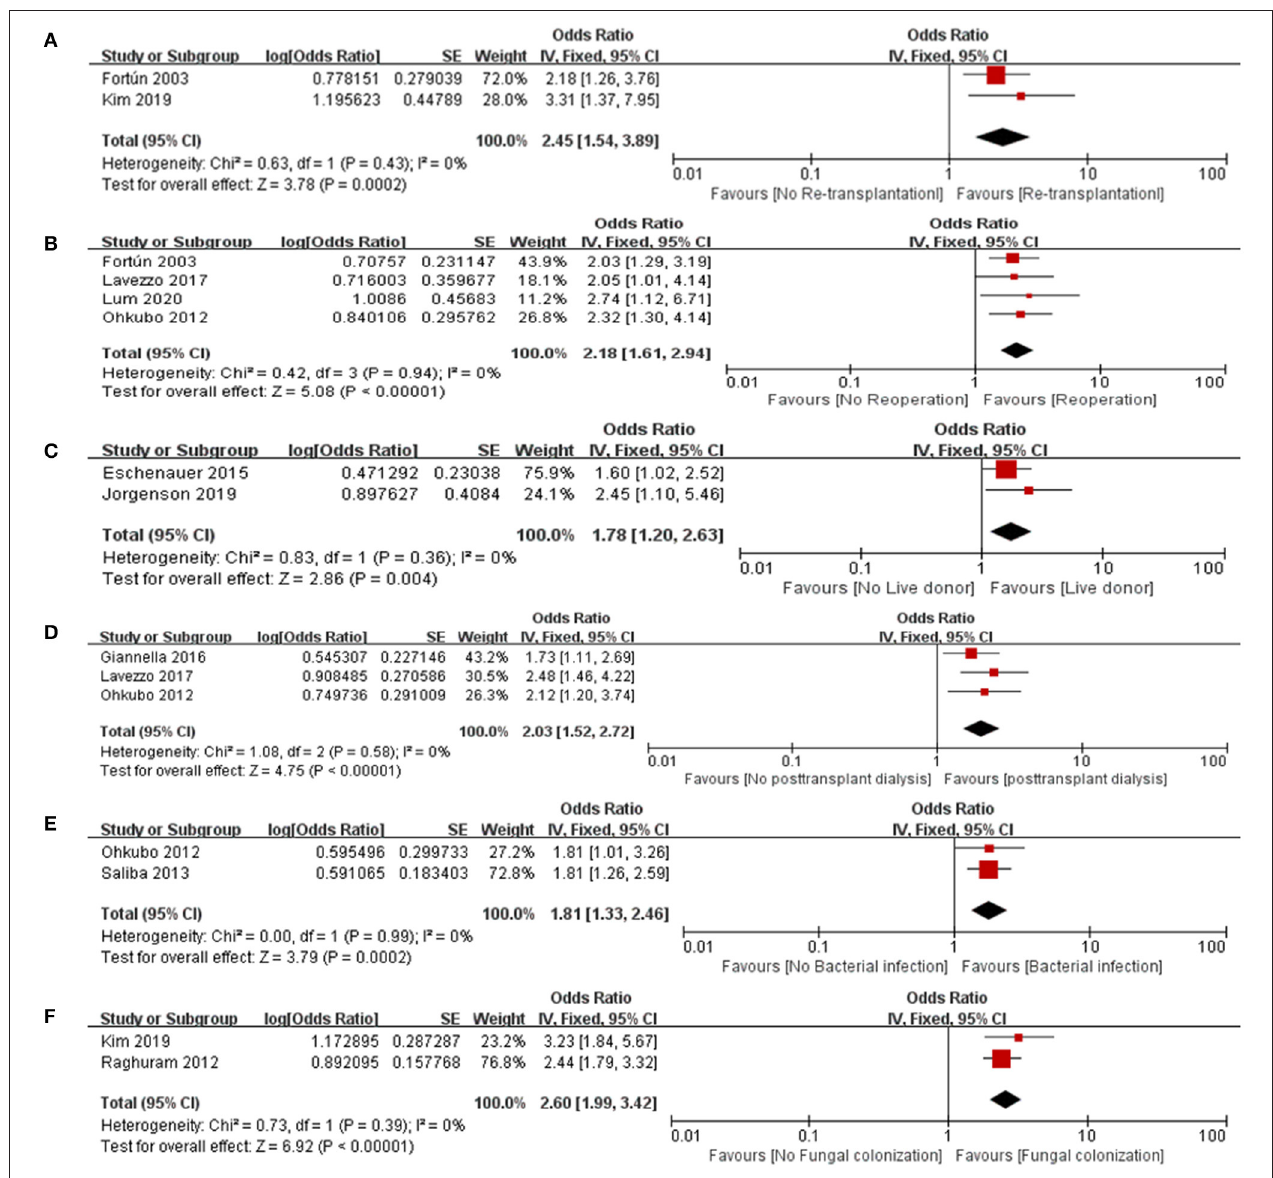
FIGURE 2 | Forest plot for the association between IFI after LT and (A) Retransplantation, (B) Reoperation, (C) Live donor, (D) Posttransplant dialysis, (E) Bacterial infection and (F) Fungal